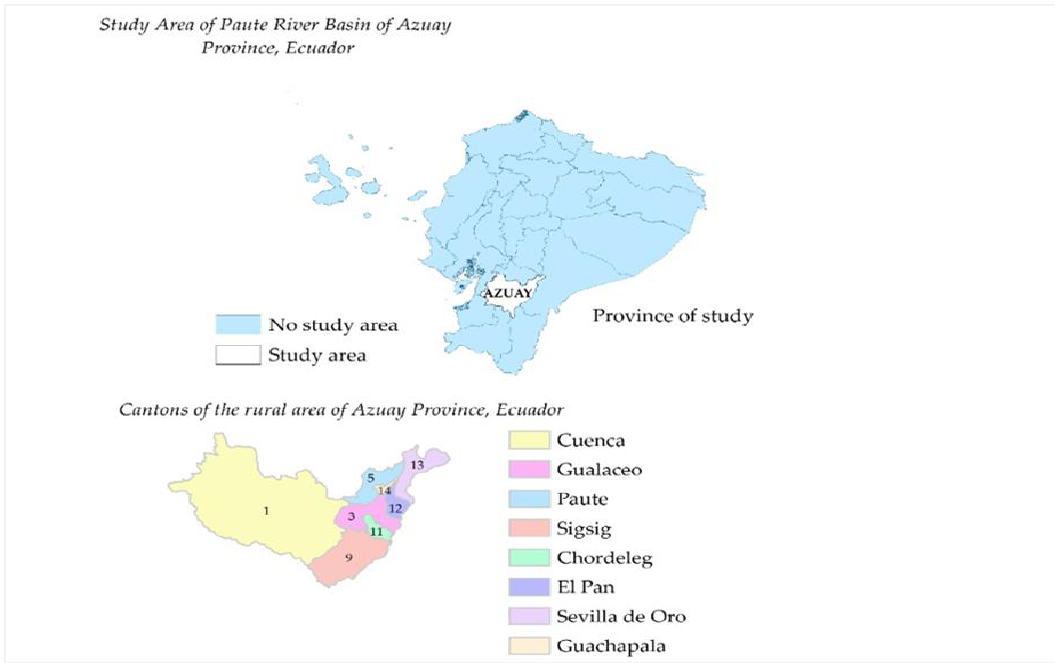
Figure 1. Location of the study area in the Paute River Basin, Azuay Province, Ecuador. Source: Authors’ own elaboration from the database.